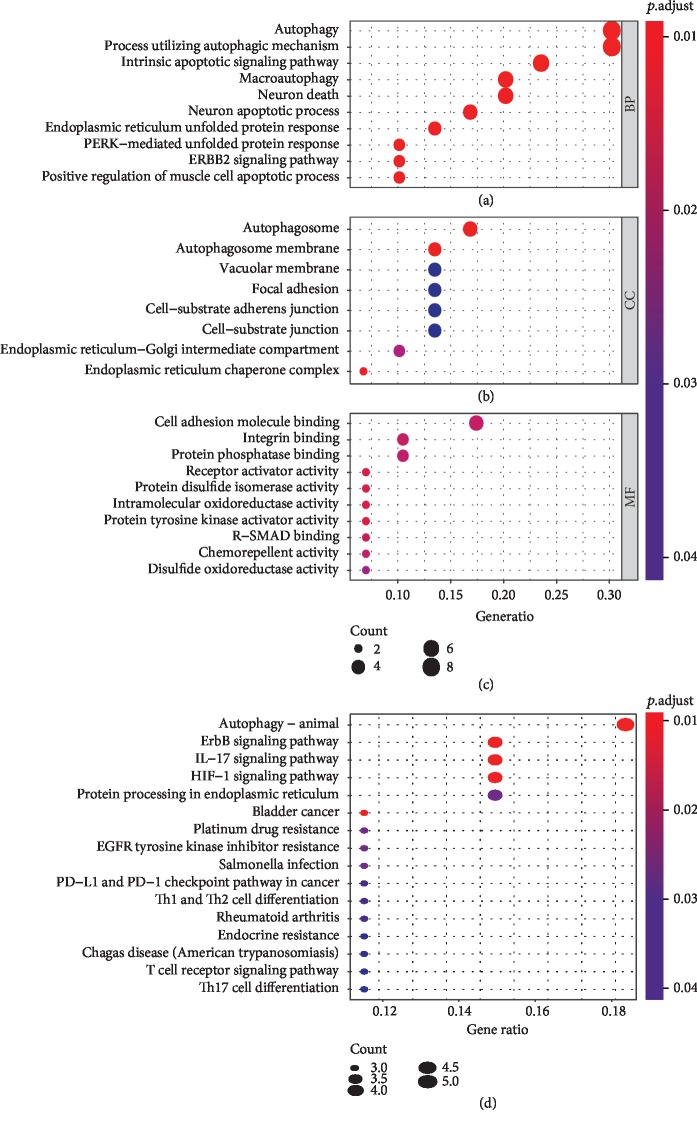
Gene functional enrichment analysis of the differentially expressed autophagy genes. (a) The top 10 biological processes in Gene Ontology analysis. (b) The top 10 cellular components in Gene Ontology analysis. (c) The top 10 molecular functions in Gene Ontology analysis. (d) The top 10 Kyoto Encyclopedia of Genes and Genomes pathways.